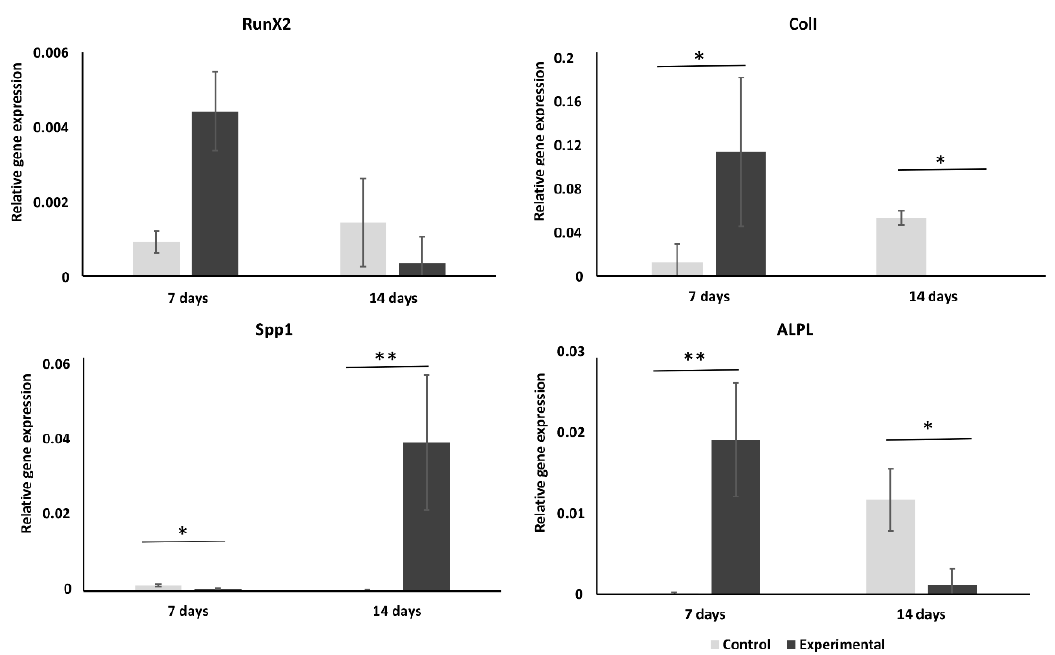
Figure 3. Osteogenic marker genes mRNAs expression in control and experimental cells. Expression of osteogenic marker genes was evaluated in experimental and control group hMSCs at days 7 and 14 of culture in osteogenic-supplemented medium. (* p < 0.05; ** p < 0.01).